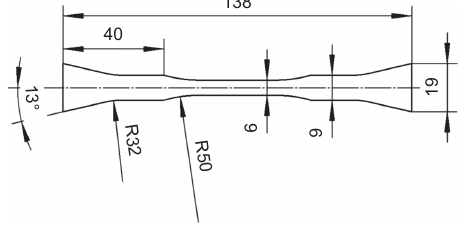
Figure 1 The geometry of specimens.